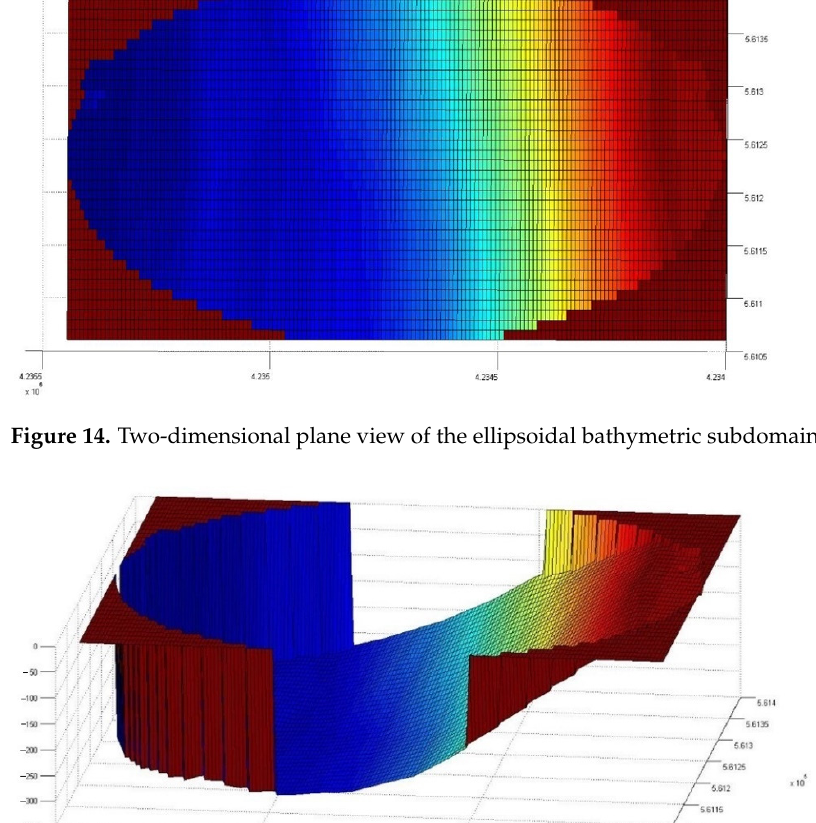
Figure 13. Three-dimensional plane view of the landslide geometric shape.